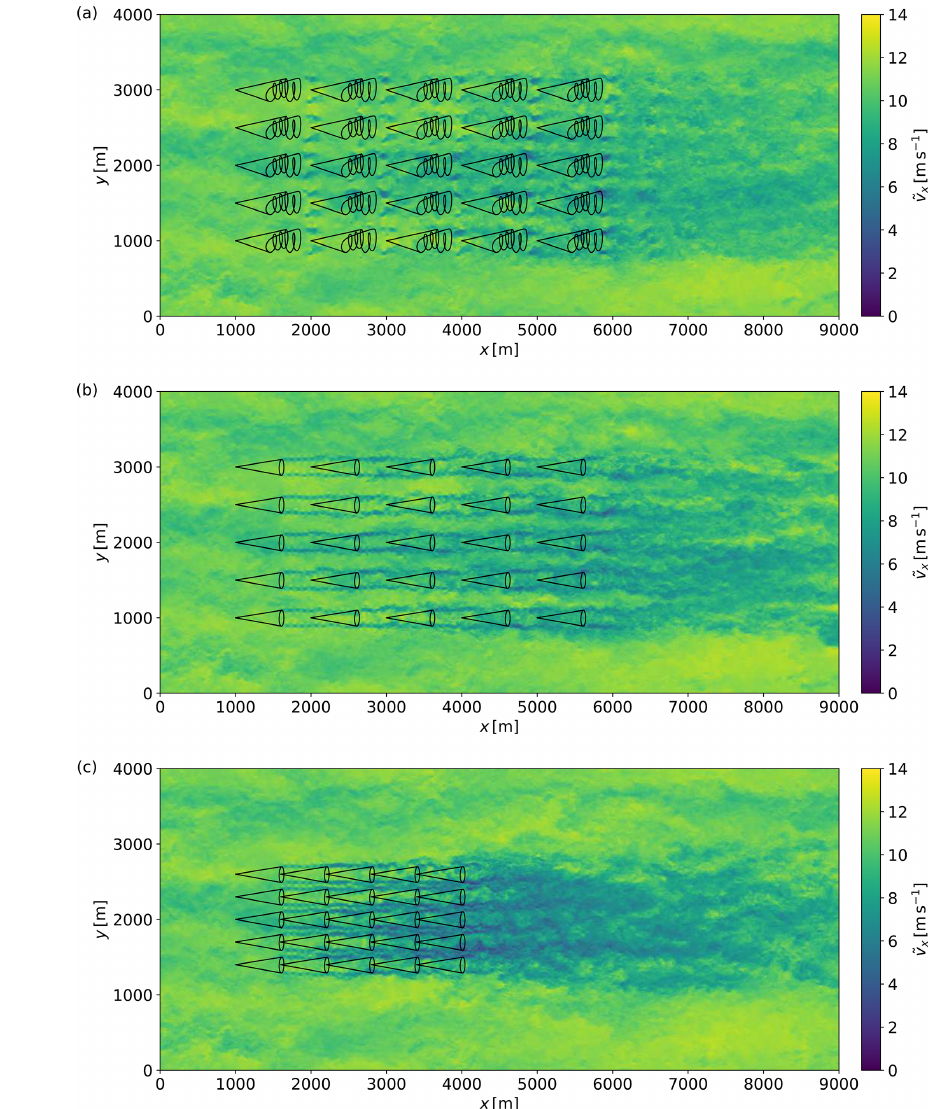
Figure 12. Instantaneous snapshot of streamwise wind velocity (cid:101) v x through the horizontal xy plane at a height z = 200m for the AWE parks L1 (a) , D1 (b) , and D2 (c) at the end of the spin-up phase. The black lines depict the park layout by showing the horizontal footprint of the AWE system